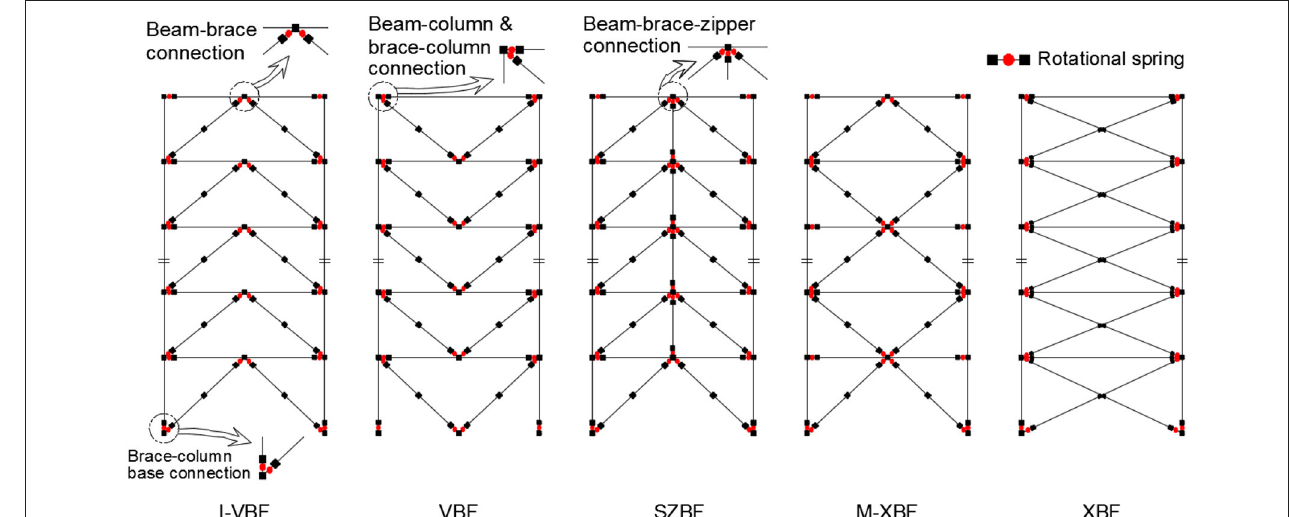
FIGURE 4 | Finite element models of